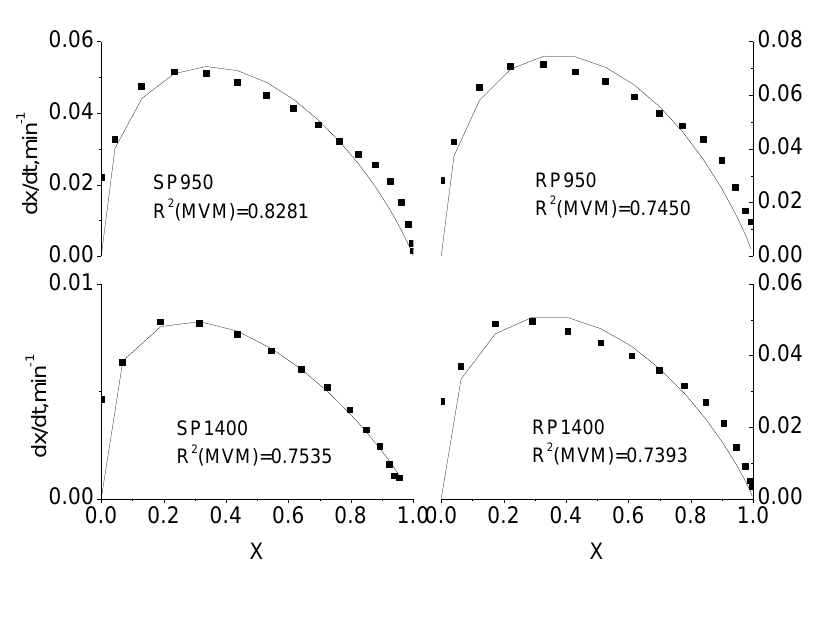
Figure 3. Reaction rate versus carbon conversion for coal char gasification at the gasification temperature of 950 °C. Experimental data ( ■ ); MVM